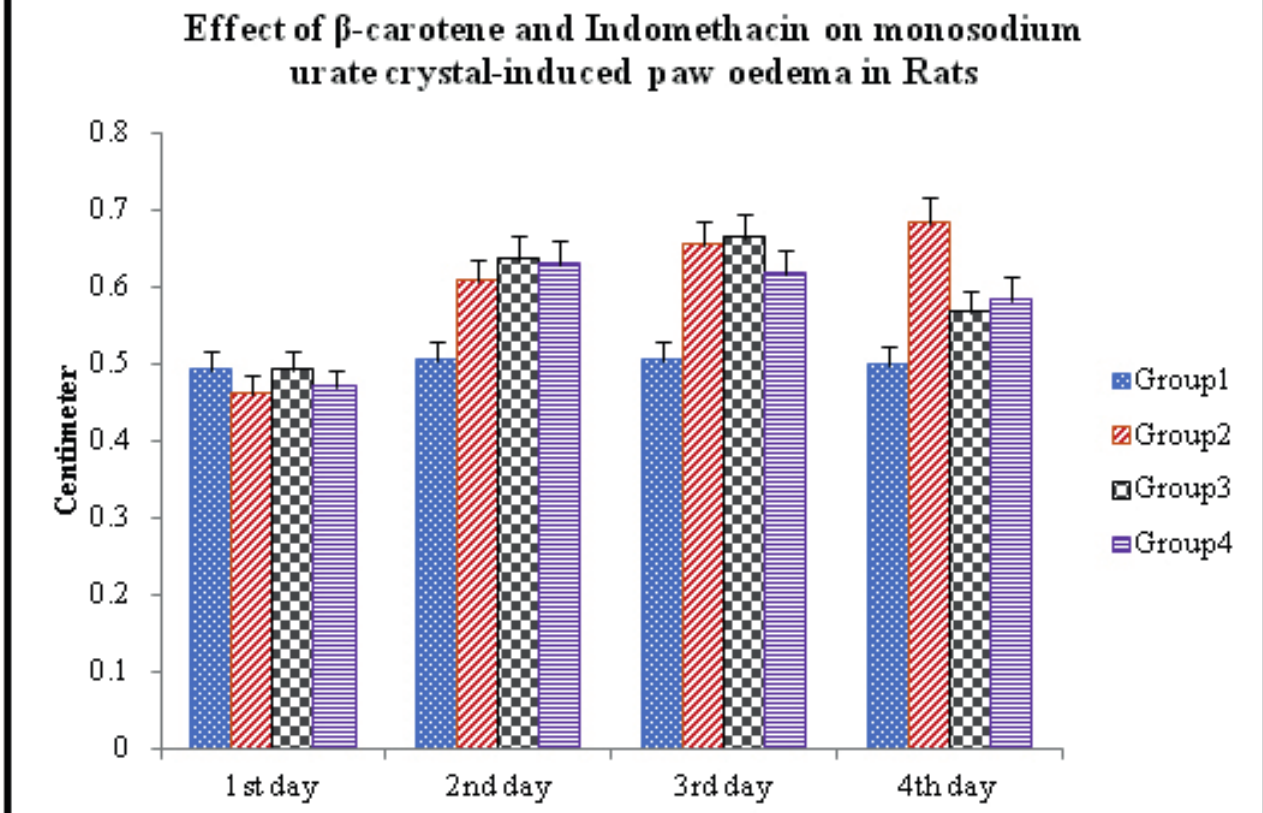
FIGURE 2 - Effect of β - carotene and Indomethacin on paw oedema of MSU crystal- induced arthritis N=6 animals in each group. The values are expressed as mean ± S.D. Comparisons indicated by lower case letters were made as follows: a – group I vs. group II, III and IV; b – group II vs. group III and IV; c – group III vs. group IV. Statistical analysis was carried out by one way ANOVA followed by Student’s Newman – Kuel’s